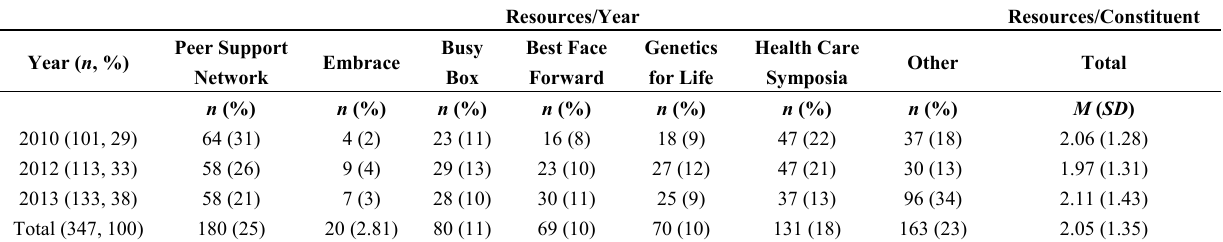
Table 2. Engagement with Evaluated Resources, Stratified by Survey Year.